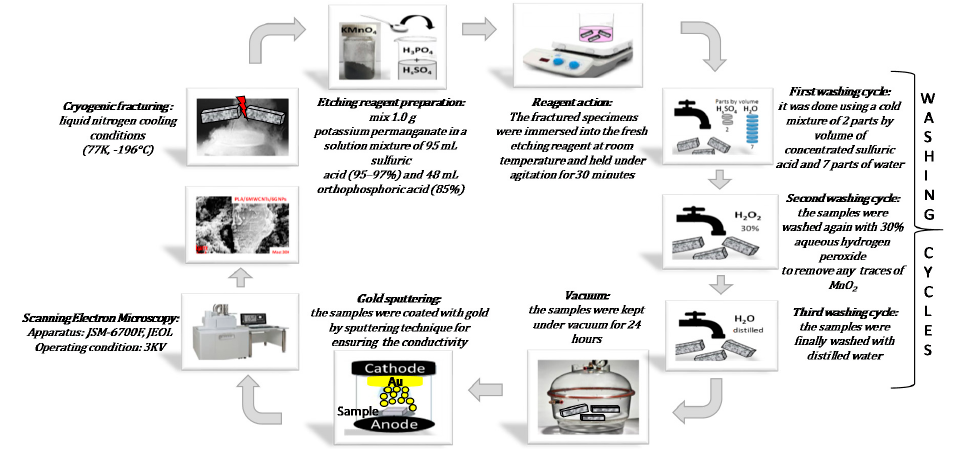
Figure 3. Summary steps for the morphological analysis.